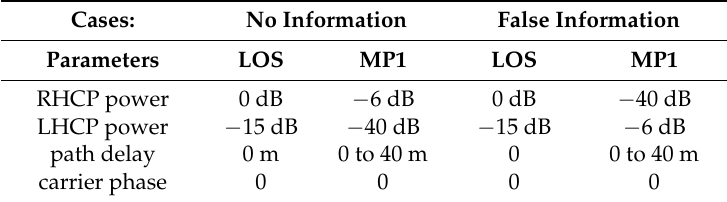
Table 6. The parameters of signals when no or false information is provided.